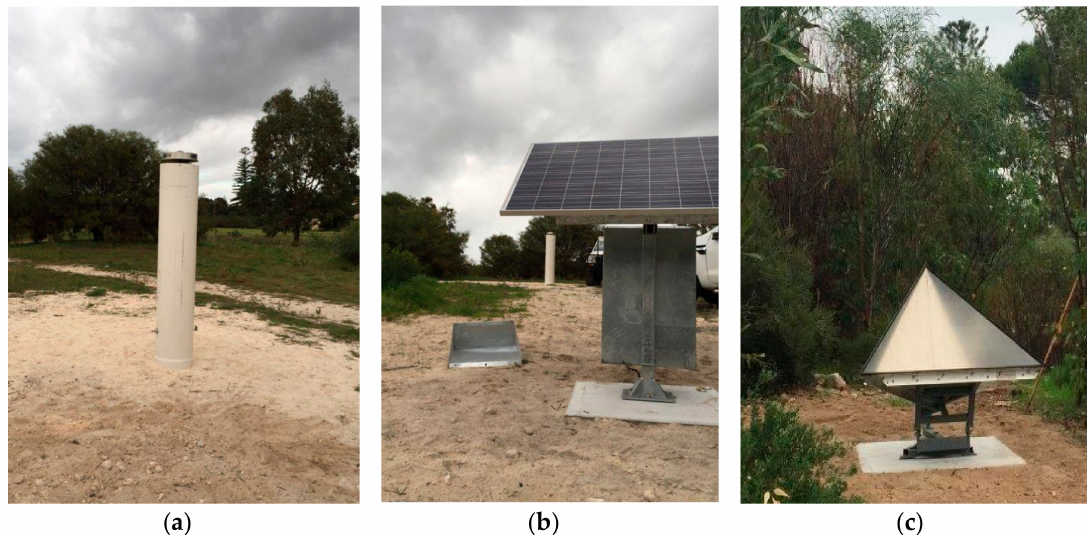
Figure 6. The co-located permanent cGNSS and corner reflector (CR) installations at FMTL (Figures 1 and 5): ( a ) two-metre-tall pillar hosting a Dorne-Margolin-type choke-ring antenna, ( b ) solar panel and padlocked housing beneath for the GNSS receiver, batteries and 4G modem, and ( c ) the CR on a concrete foundation. Images courtesy of Ken